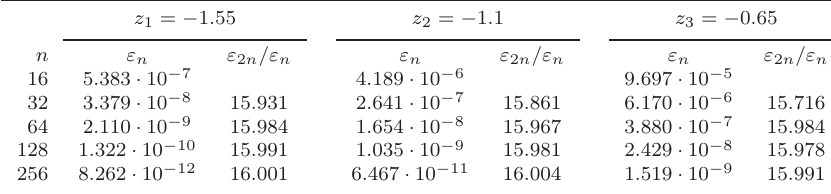
Table 1. Numerical results for y ( x ) = x − 2 , ε n = S ( z i ) − y ( z i ) , i = 1 , 2 , 3 . z 1 = − 1 . 55 z 2 = − 1 . 1 z 3 = − 0 . 65